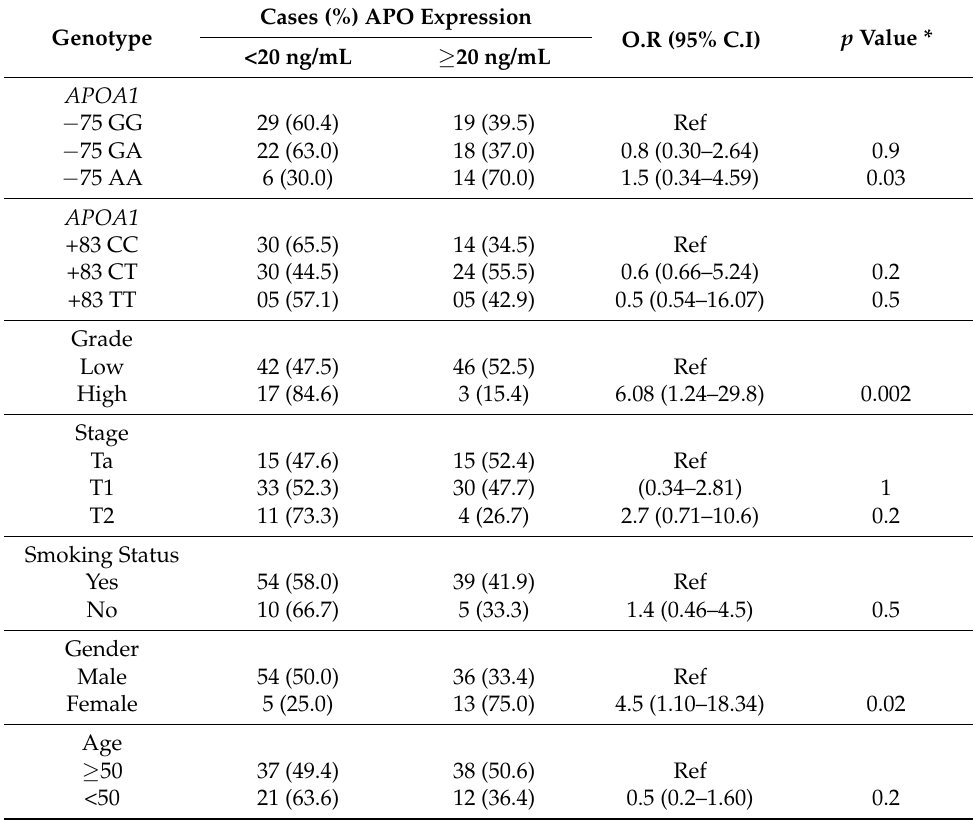
Table 4. Urinary protein expression of APOA1 with respect to clinic o-pathological features and APOA1 genotypes in bladder cancer